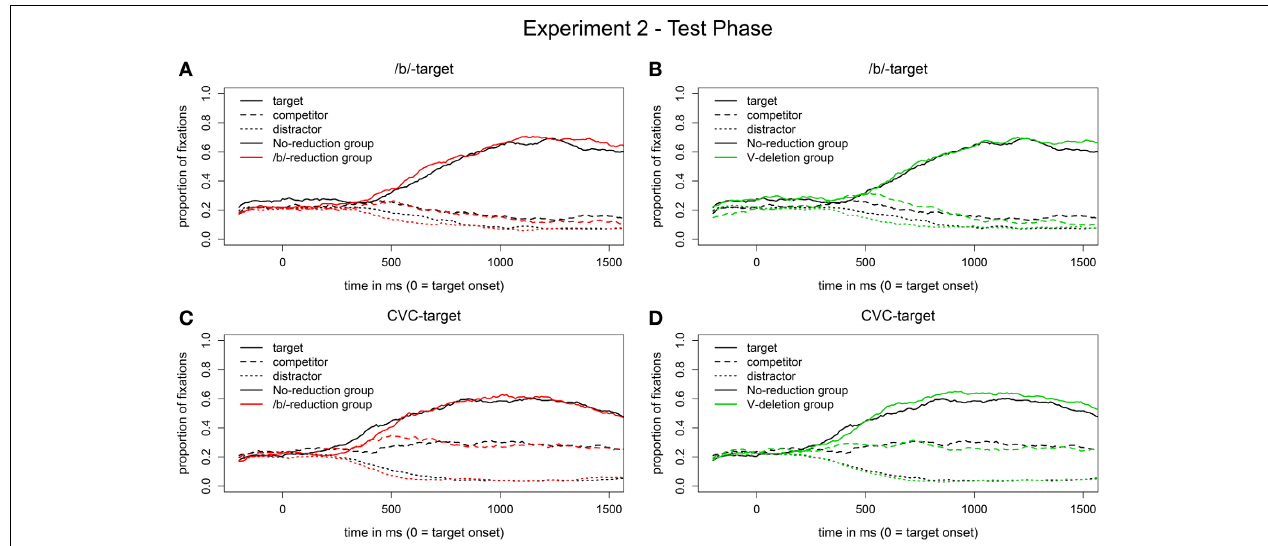
FIGURE 5 | Proportion of fixations in the segmental reduction condition [reduced /b/-words in auditory input, visual /b/-targets on screen; (A,B)] and in the syllabic reduction condition [vowel-deleted words in auditory input, visual CVC-targets on screen; (C,D)] in the test phase of Experiment 2.